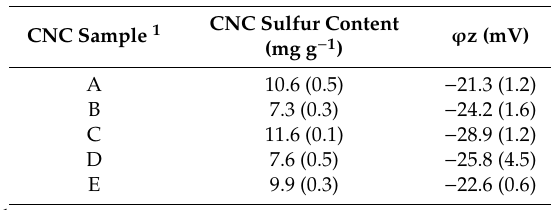
Table 4. Sulfur content and Zeta potential values for CNC obtained from hydrolysis treatment.